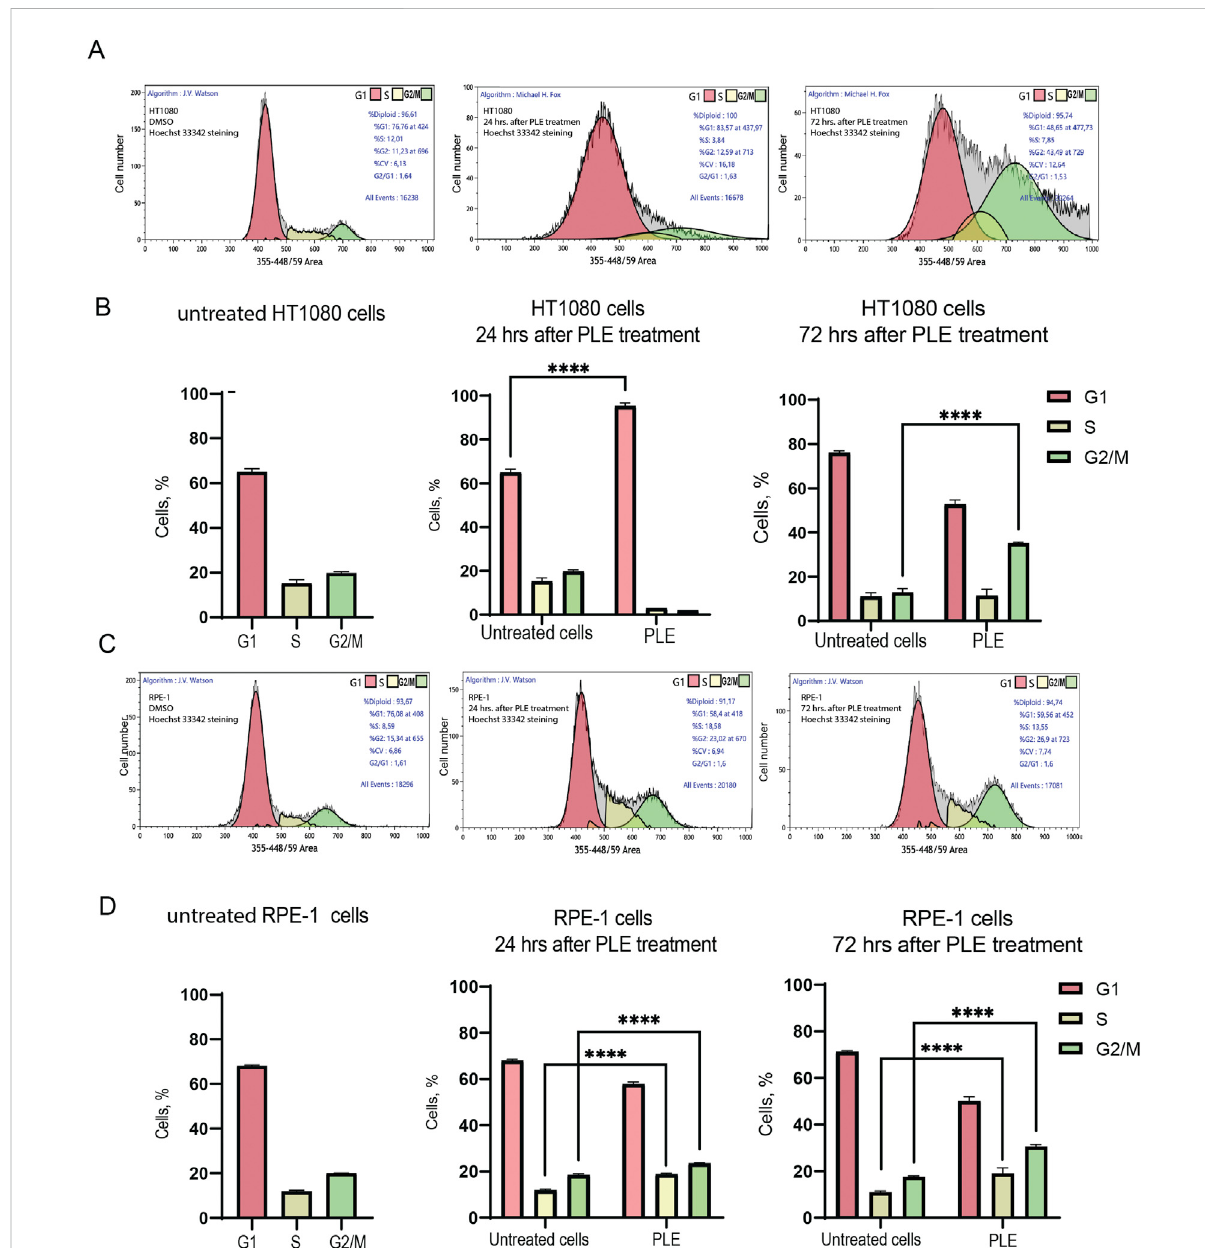
Analysis of the cell cycle after PLE treatment. (A) Flow cytometry analysis of HT1080 untreated cells 24 and 72 h after PLE treatment. (B) The percentage of cells in G1, S and G2/M phases in HT1080 cell population after 24 and 72 h. (C) Flow cytometry analysis of RPE-1 untreated cells